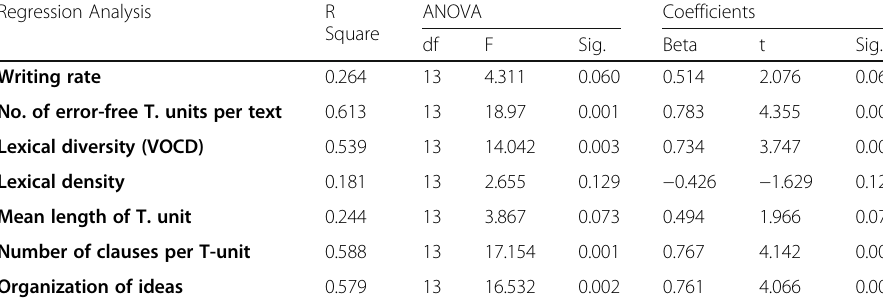
Table 7 Regression analysis for the time range of exposure to the suggested YouTube channel Regression Analysis R ANOVA Square